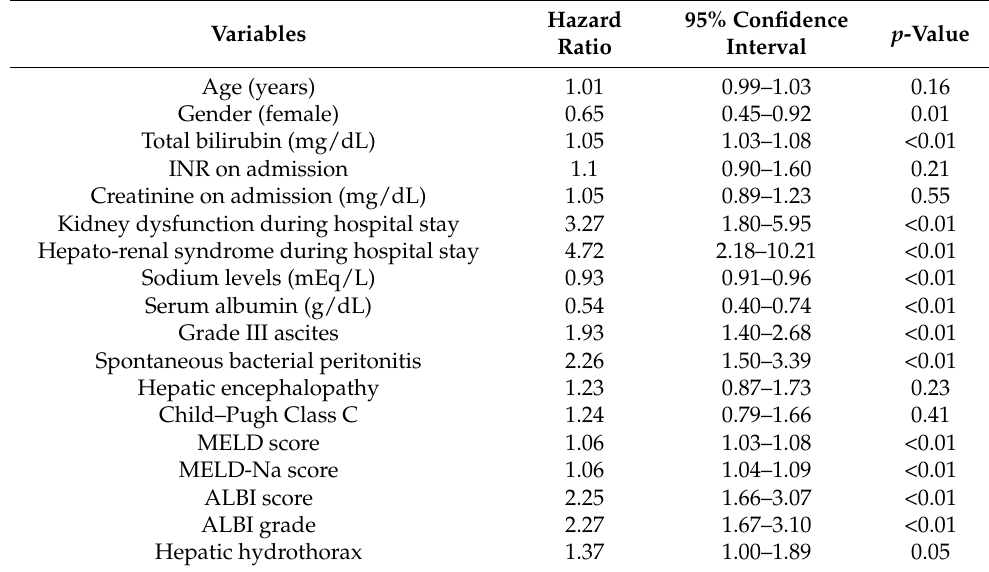
Table 2. Univariate Cox proportional hazards model in the entire matched cohort ( n = 194 patients).